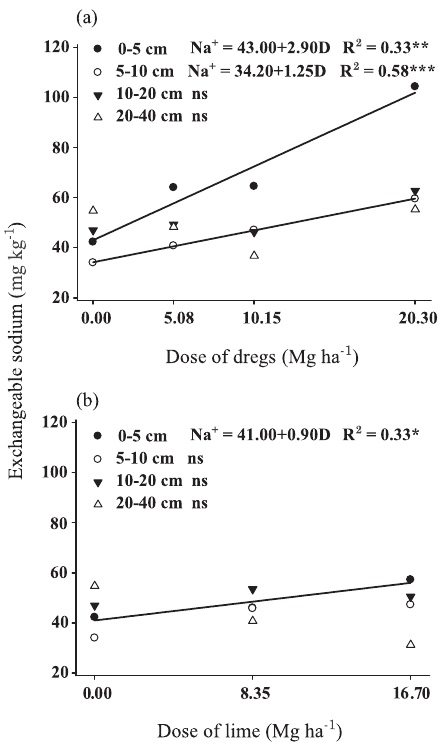
figure 4. exchangeable sodium (na + ) in the layers of a humic cambisol amended with doses (d) of dregs (a) and lime (b) applied to the soil surface in 2004/2006. Bocaina do sul, sc, 2010. (*, **, *** and ns: significant at 5, 1, 0.1 % and not significant,